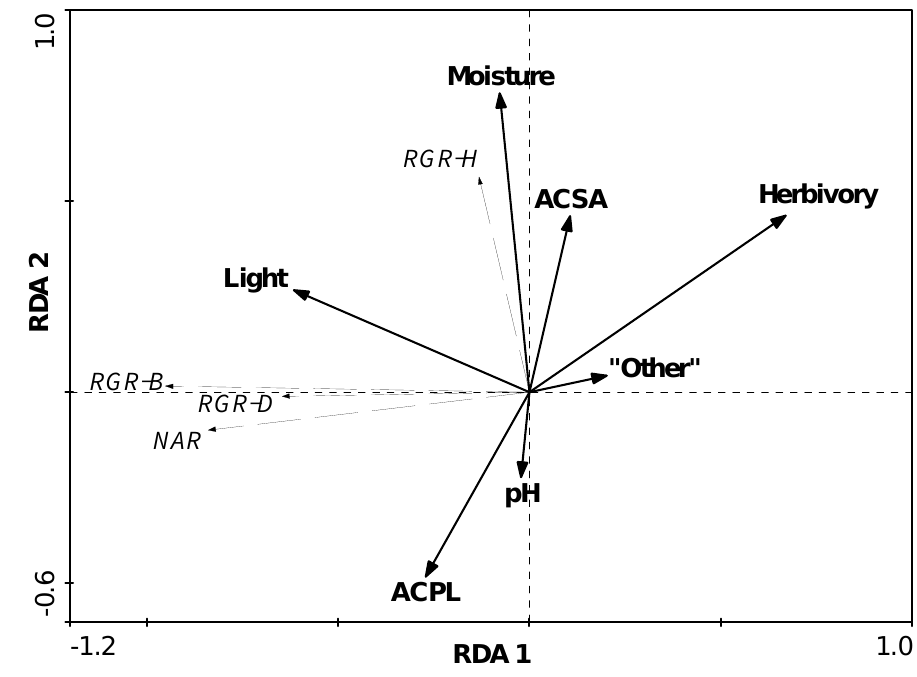
Figure 2. RDA correlation biplot representing growth parameters (dashed vectors) and ecological factors (solid vectors) of A. saccharum seedlings ( n = 56). The first and second canonical axes explain respectively 19.4% and 3.1% of variation in the